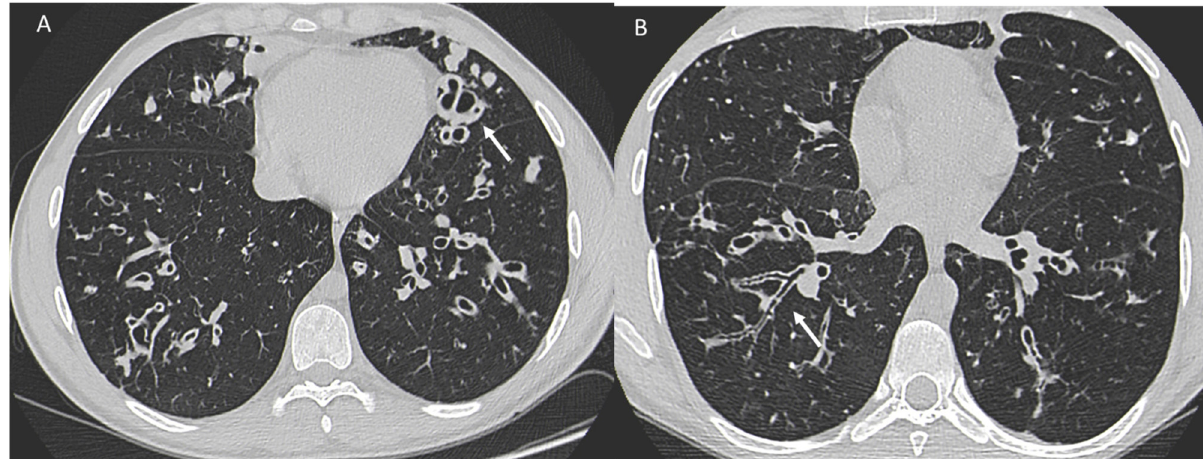
Figure 3. A woman and a man with CF with di ff erent and higher anatomo-structural involvement at HRCT in women with CF compared with men. ( A ) Diffuse cystic-varicoid bronchiectasis, with diffuse wall thickening and mucous plug (white arrow) in a young woman patient with cystic fibrosis. ( B ) Bronchiectasis with thickened walls (white arrow), especially in the medium-lower pulmonary lobes in a male patient with cystic fi brosis.